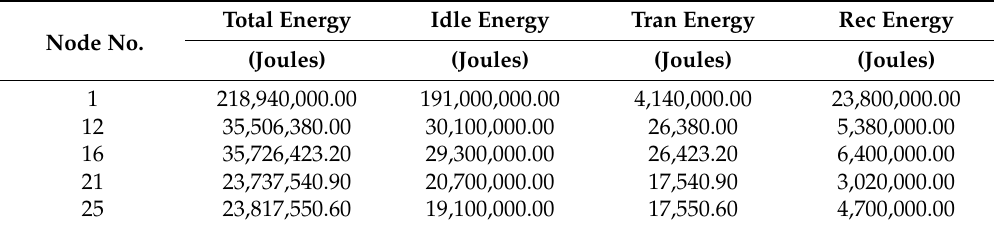
Table 8. Energy Measurements before node 1 is affected by rain.